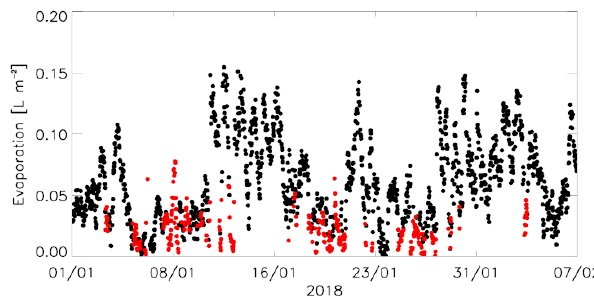
Figure 5. The 30min time series of the evaporation obtained with the EC method: the red dots indicate the measurements coming from outside the